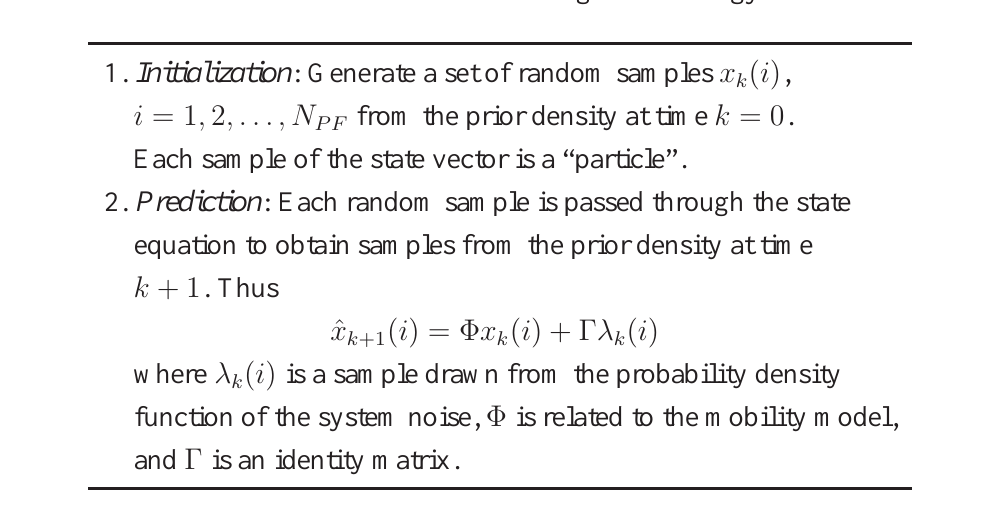
Table 1. The Particle Filtering